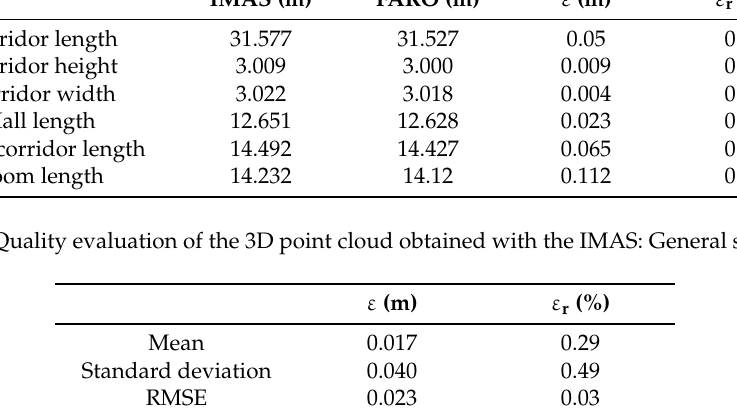
Table 3. Quality evaluation of the 3D point cloud obtained with the IMAS: General statistics.